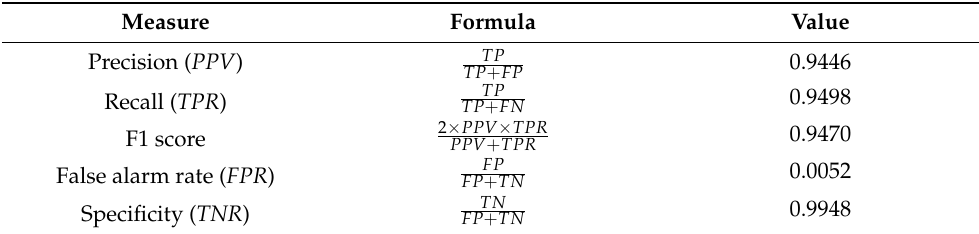
Table 8. Calculated performance measures of Task